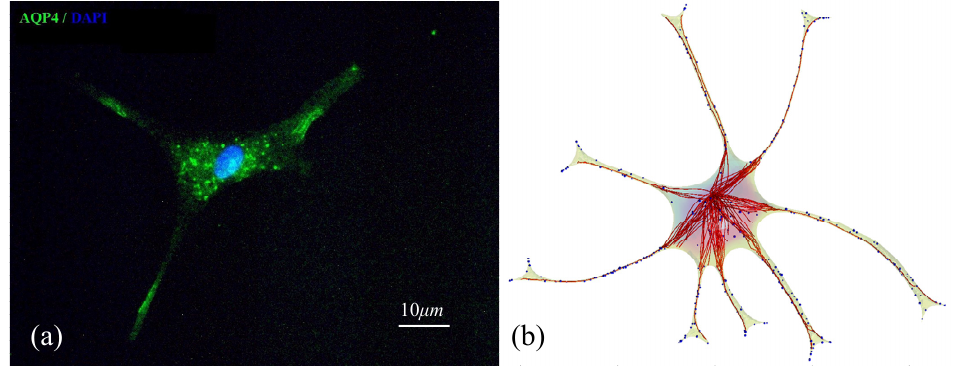
Figure 6. AQP4 trafficking in primary cultured astrocytes ( a ) and in the cell simulator ( b ). In ( a ), AQP4 proteins are seen in vesicles in the cell body as well as along astrocytic processes during their transport towards the endfeet. In ( b ), microtubules (red) and associated transport vesicles containing AQP4 (blue) in the reconstructed astrocyte cell are visualized.